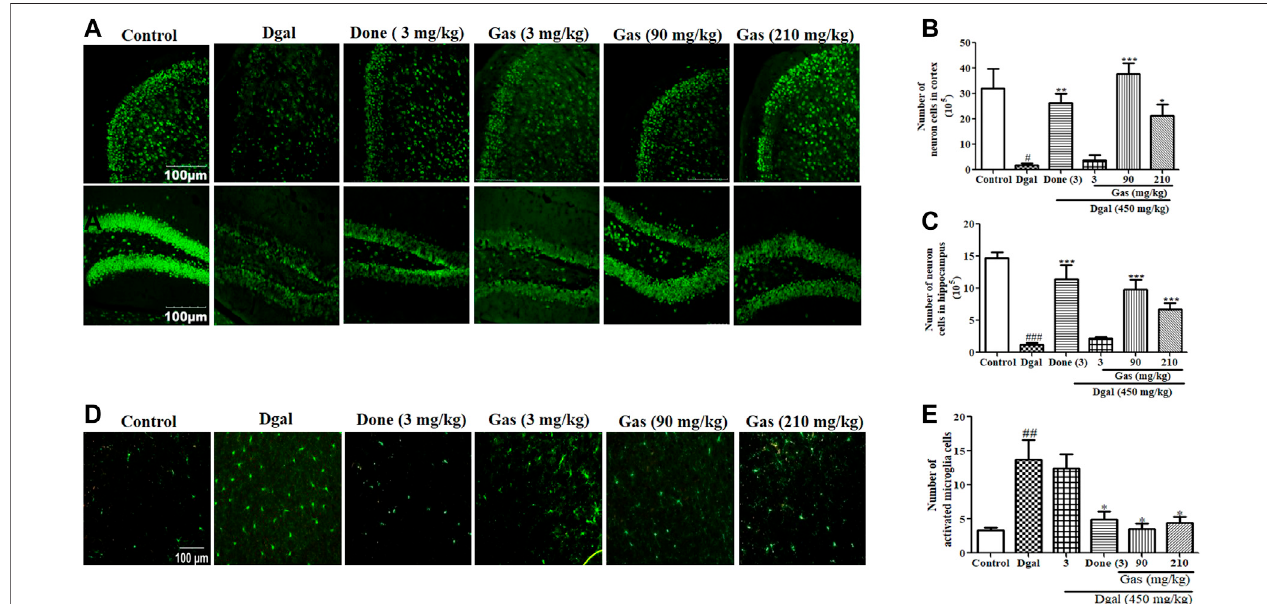
FIGURE3| GaspromotesneuroprotectionandmitigatesmicroglialactivationinDgal-inducedADmice. (A) Fluorescentimageofneuronsinthehippocampusand cerebralcortex ofallgroups. (B) and (C) representdigitalnumber ofneuronsinthecerebral cortex andhippocampus, respectively. (D) Fluorescent image ofmicroglia in the cerebral cortex. (E) Digital number of microglia in the cerebral cortex. The brains of three mice in each group were cut, and six sections of the cerebral cortex and hippocampus of each mouse were used to calculate neurons or microglia. The data were presented as means ± SEM. ## and ### indicate signi fi cant differences at p < 0.01 and p < 0.001 compared with those of the normal control, respectively; *, **, and *** indicate signi fi cant difference at p < 0.05, p < 0.01, and p < 0.001 compared with those of the Dgal group,